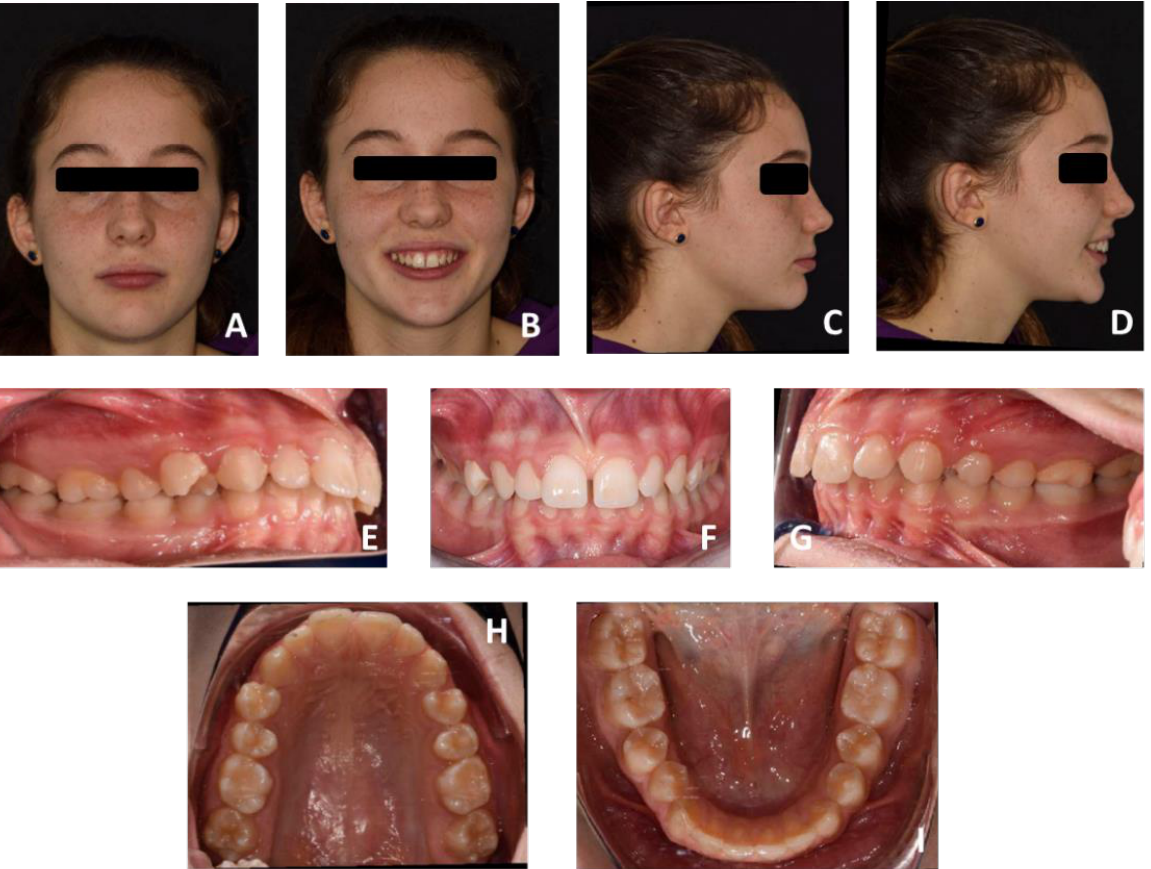
Figure 15. Pre-treatment intraoral and extraoral photos of case number 2: frontal facial view ( A ); frontal facial view smiling ( B ); right facial view ( C ); right facial view smiling ( D ); right arches view ( E ); frontal arches view ( F ); left arches view ( G ); upper arch occlusal view ( H ); lower arch occlusal view ( I ).